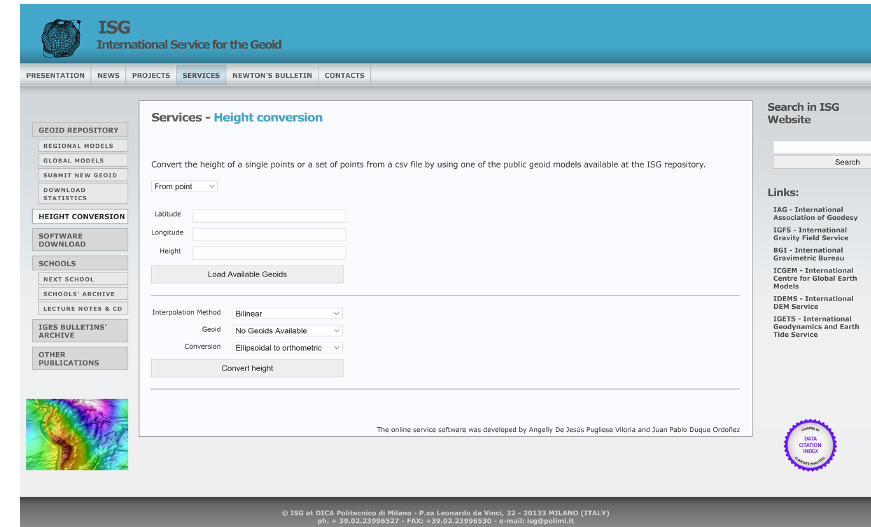
Figure 4. Web page to access the ISG height conversion web service.